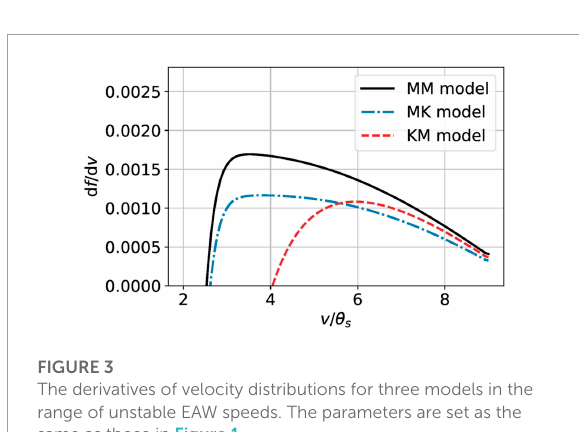
FIGURE 3 The derivatives of velocity distributions for three models in the range of unstable EAW speeds. The parameters are set as the same as those in Figure 1